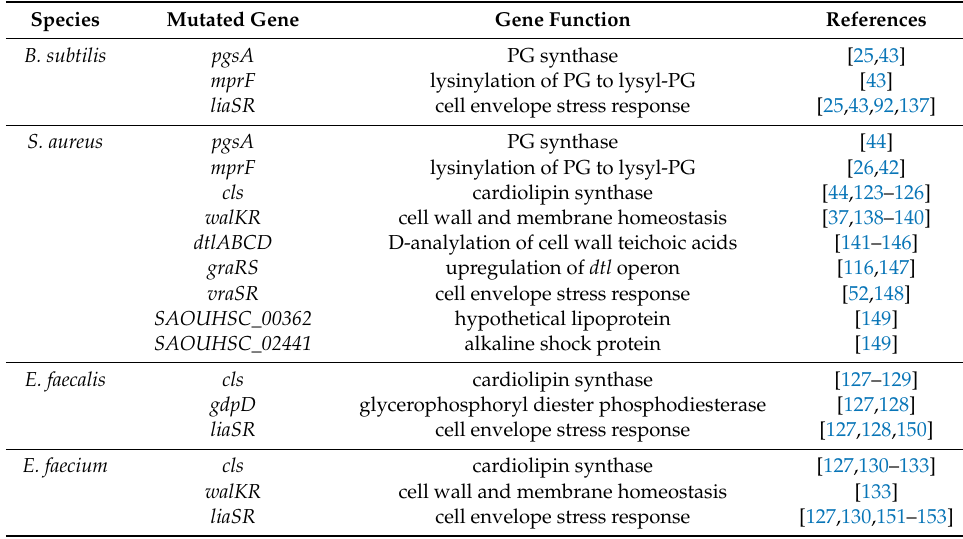
Table 1. Mutations that confer daptomycin